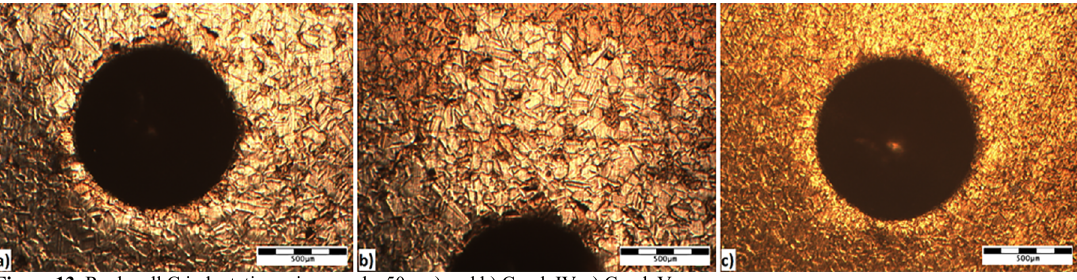
Figure 13. Rockwell C indentation micrographs 50x: a) and b) Cond. IV, c) Cond.